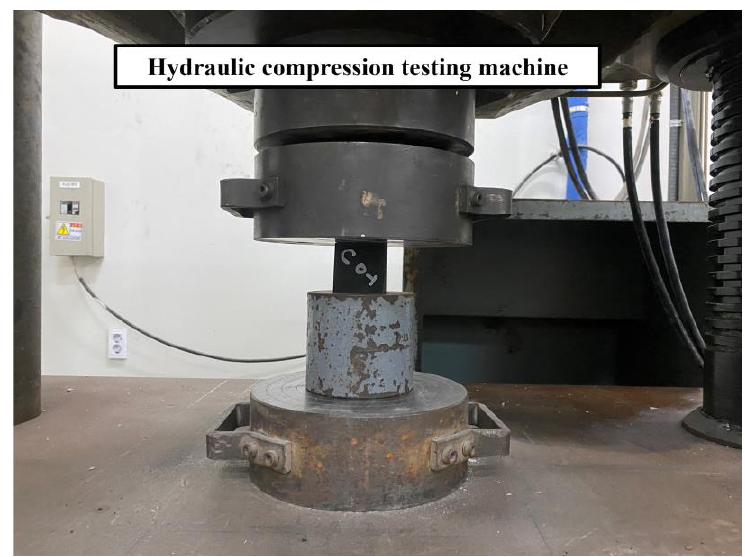
Figure 5. Compressive strength test set-up.